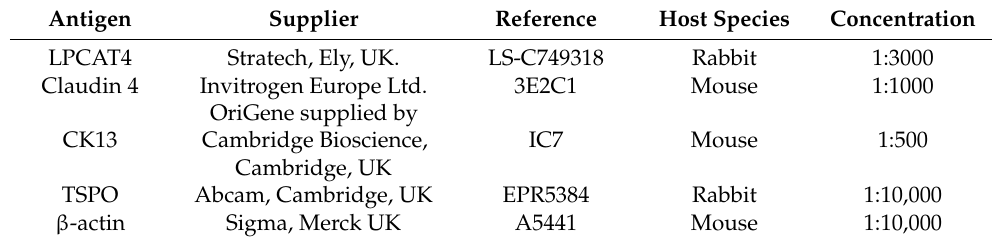
Table 1. Primary antibodies used in Western blotting